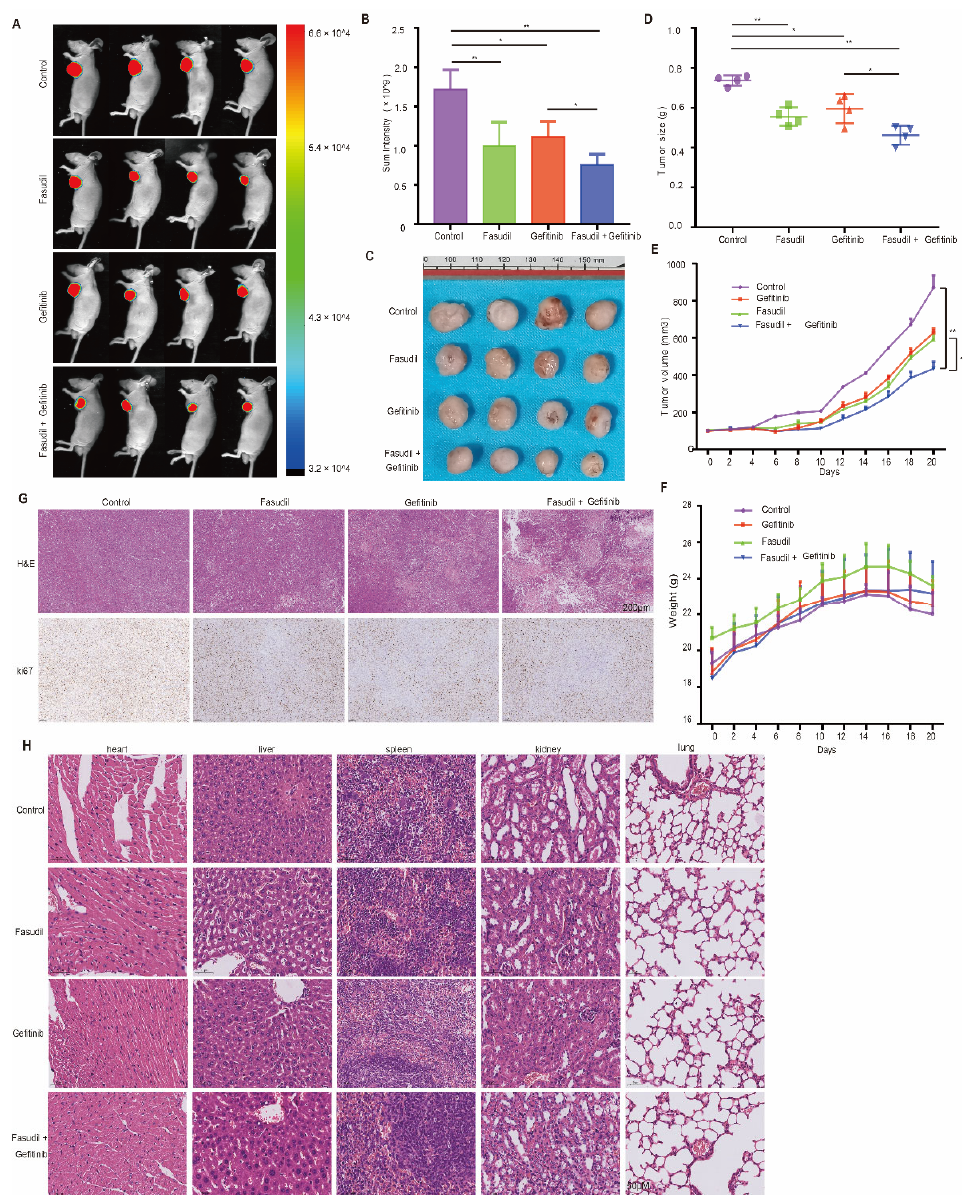
lower in the combination group than in the other groups.